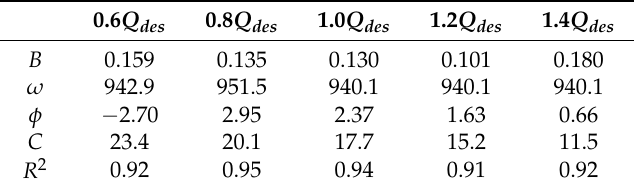
Table 5. Fitting parameters for efficiency fluctuation in different working conditions.